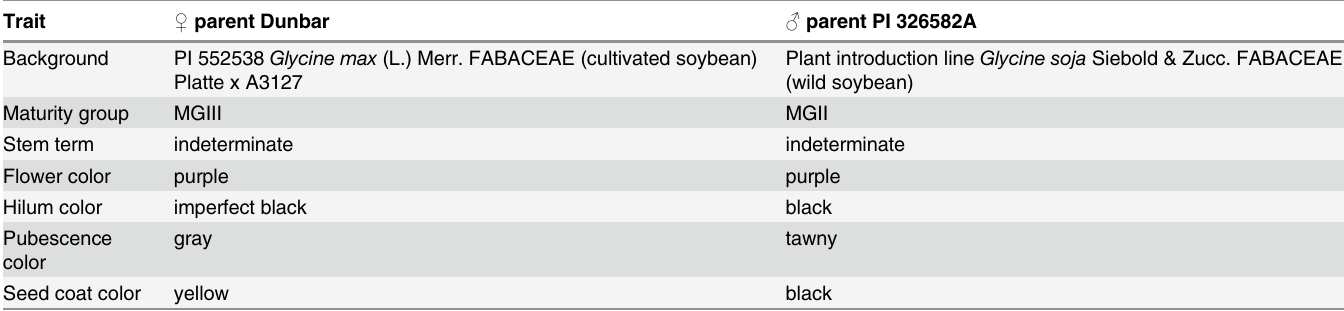
Table 1. Growth characteristics of the parental lines used in the study. Trait ♀ parent Dunbar ♂ parent PI 326582A